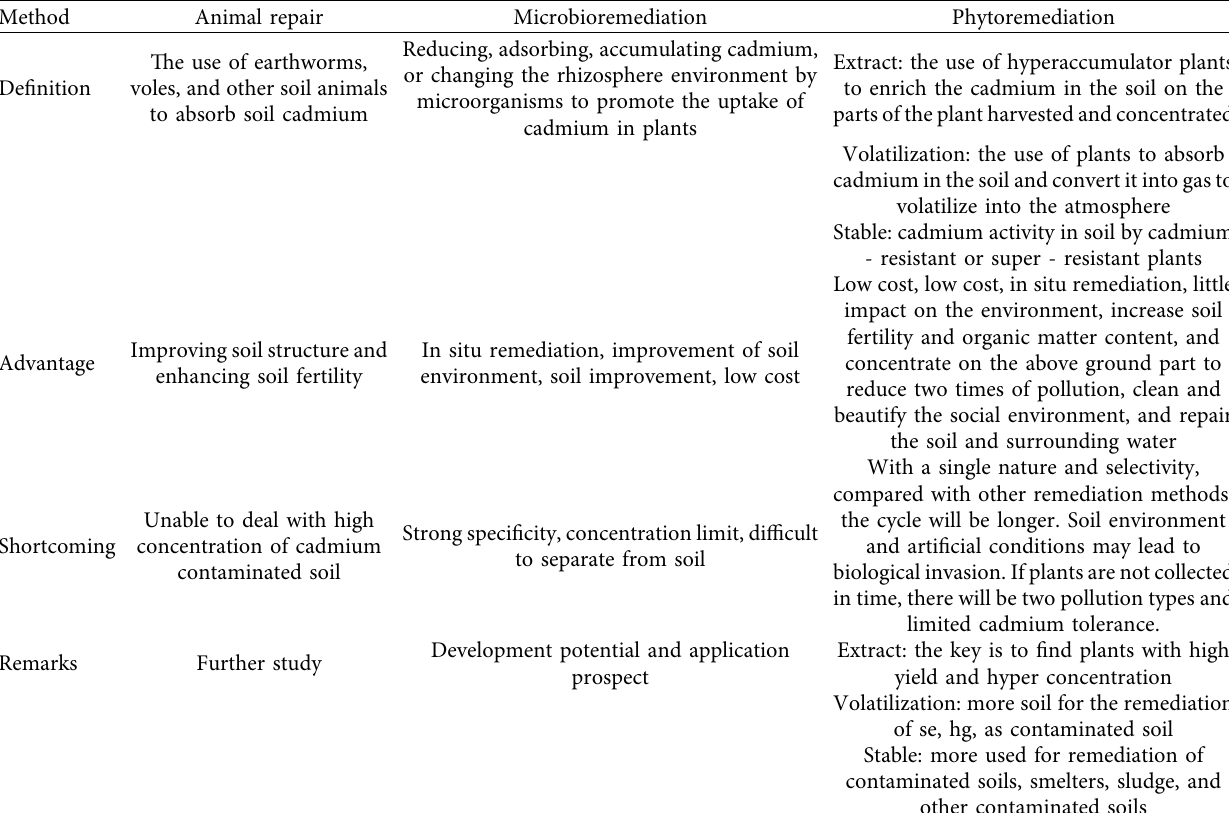
Table 2: Bioremediation of cadmium pollution in